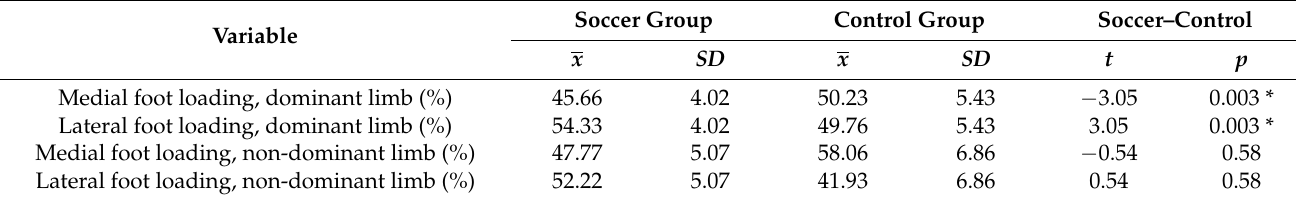
Table 6. Mean ( x ), standard deviation (SD) and t-test results for plantar pressure distribution in the dominant and non-dominant limbs (medial/lateral loading) in the dynamic